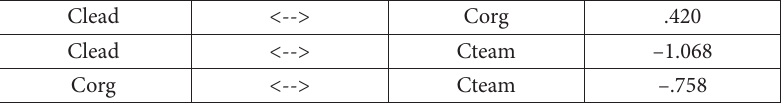
Table 4. Correlations between latent variables of communication in respecified model (source: created by